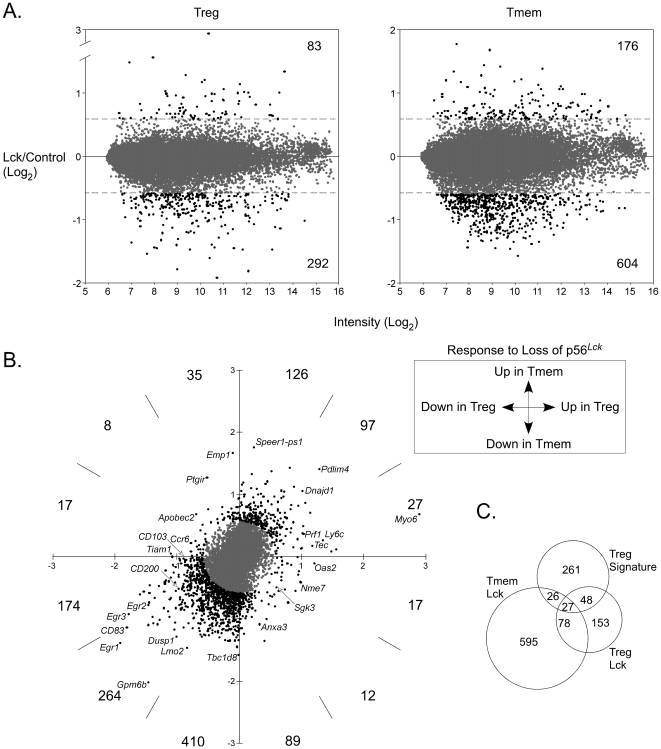
Gene expression in Lck-mutant regulatory T cells.A. The graphs show normalized log2 ratios of hybridization signals (Lck/Control) versus average hybridization intensity for all spots on the microarrays. Ratios corresponding to greater than 1.5-fold changes in spot intensity (dotted lines) are colored black instead of grey, and the numbers of these are indicated at the top and bottom right of the graphs. RNA was purified from flow-sorted Treg cells (CD4+CD25+) labeled differentially according to its origin (Lck mutant vs. control) and hybridized to microarrays spotted with 70-mer oligos from the MEEBO collection as described in Methods and Materials. B. Bivariate plot of Lck/Control spot ratios in memory versus regulatory T cells. Numbers of spots with vectors greater than 1.5 (colored black instead of grey) in the indicated parts of the four quadrants are shown. C. Venn diagram showing overlap between genes that are differentially expressed in control versus Lck memory and/or Treg cells and the Treg signature gene set identified by Hill et al. [40].